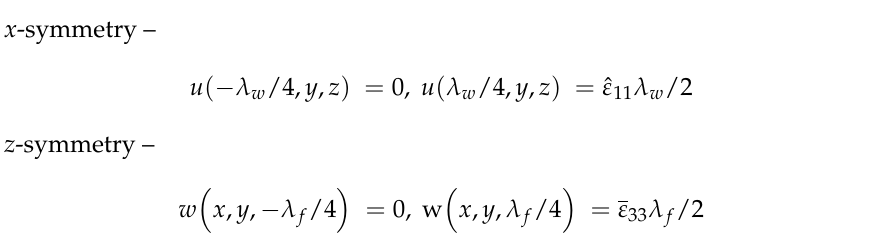
Figure 4. Fiber tow arrangement in the thickness direction: ( a ) in-phase ( ∆ x = 0); ( b ) shifted ( ∆ x = λ w /4); and ( c ) symmetric ( ∆ x = λ w